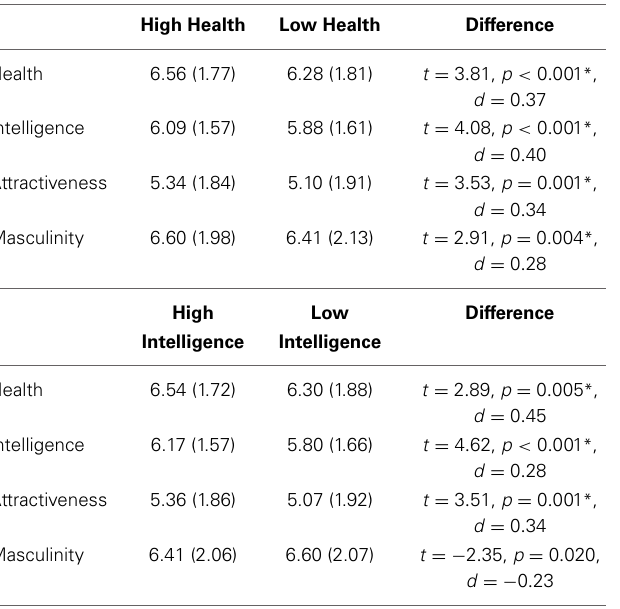
Table 2 | Sample 2 ( N = 148) Ratings of high health vs. low health faces, and ratings of high intelligence vs. low intelligence faces—Means, SDs, t -tests, and Cohen’s